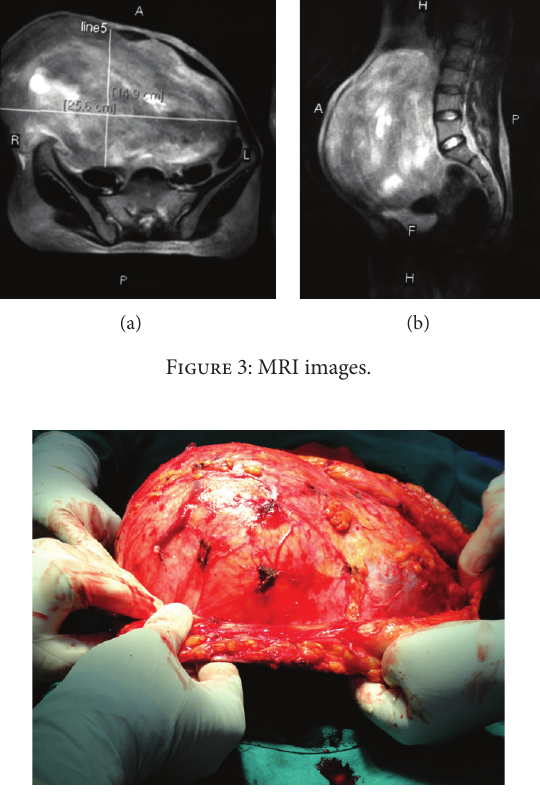
Figure 4: Intraoperative